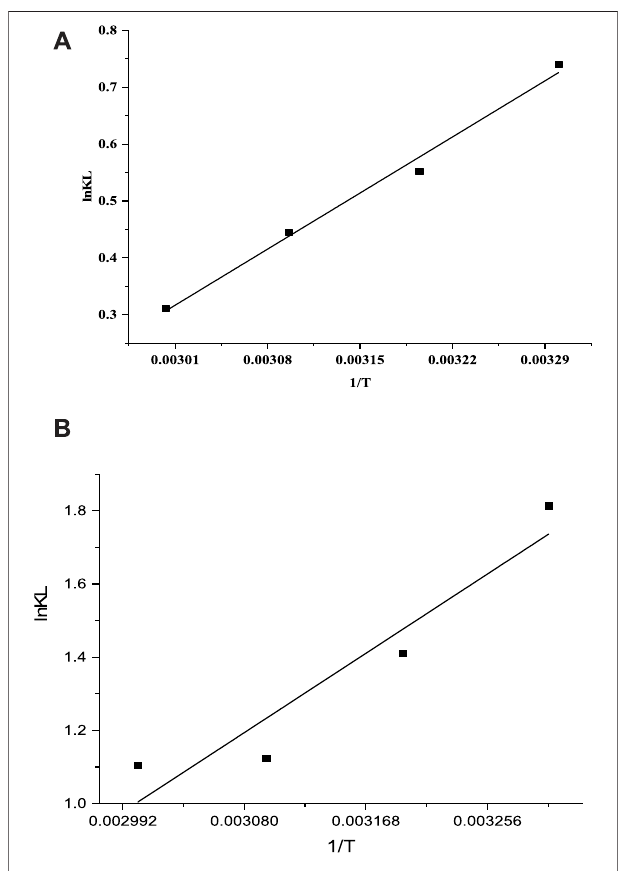
FIGURE 14 | Linear fi tting on the adsorption data of (A) chromium and (B) lead.